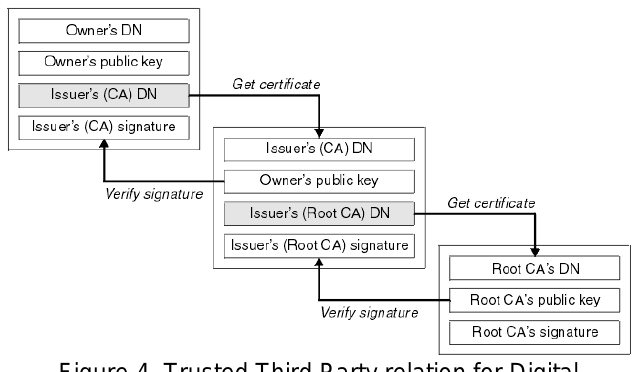
Figure 4. Trusted Third Party relation for Digital certificate